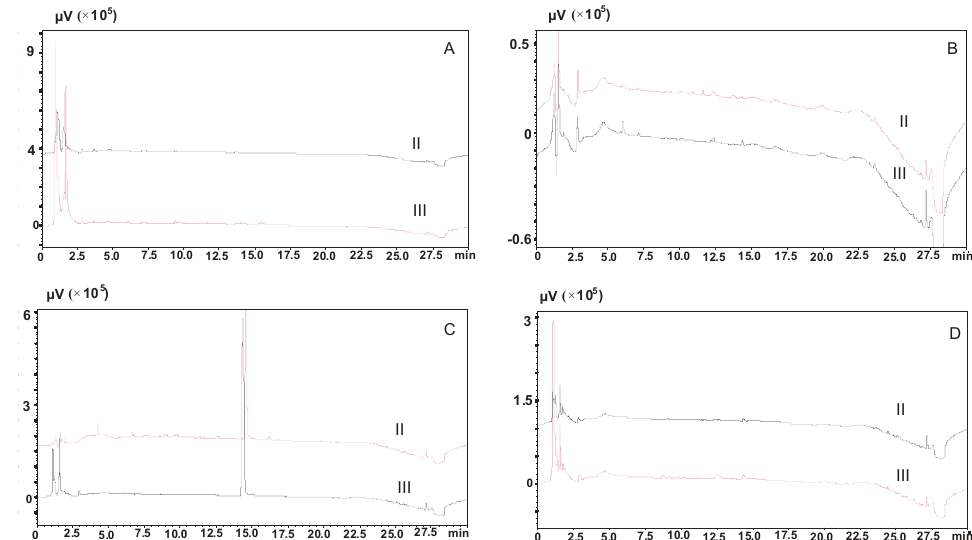
Figure 3. Chromatograms of blank saliva samples after elution of column with modification of the pH of the sample dilution solution and the elution solution. ( A )—procedure 25, ( B )—procedure 26, ( C )—procedure 27, ( D )—procedure 28; II—Strata X-C columns, III—Strata X-CW columns.